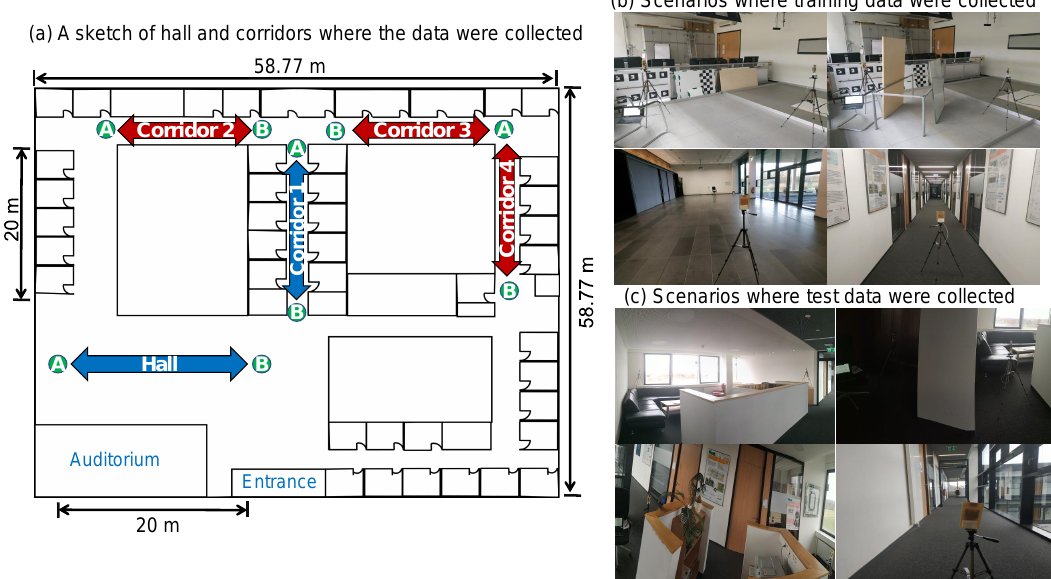
Figure 3. Illustration of the scenarios where training and test data were collected for evaluation: ( a ) A sketch of the building where the experimental data for training and test were collected. ( b ) Training data were collected for LOS, NLOS (including human blocking) and MP conditions in a laboratory, a large hall, and a corridor (blue color in ( a )). ( c ) Similar to ( b ), test data were collected in a different room (including different types of furniture and NLOS human blocking) and a different corridor (red in ( a